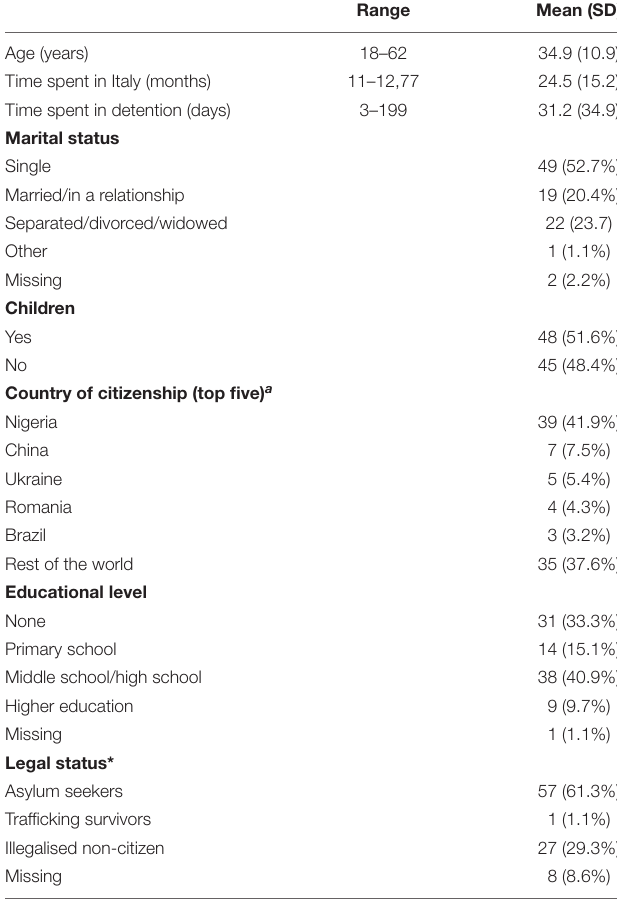
TABLE 1 | Demographic characteristics of